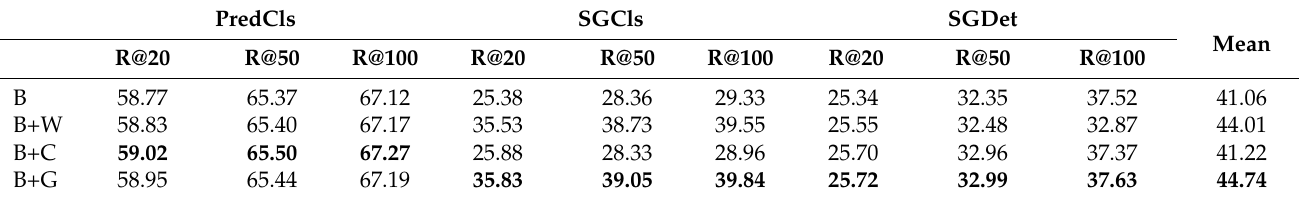
Table 4. Influence of different types of external knowledge on R@K.